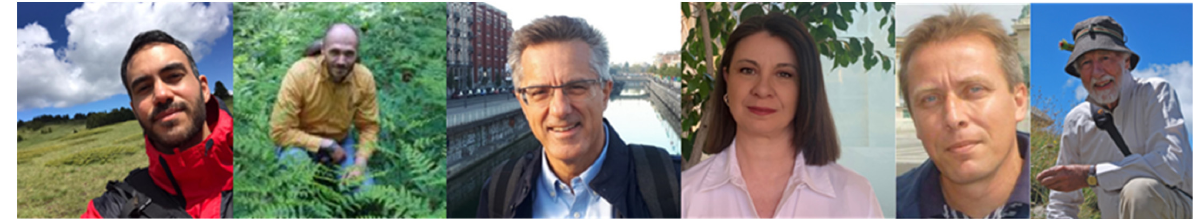
Figure 3. Konstantinos Kougioumoutzis, Ioannis Kokkoris, Panayotis Dimopoulos, Maria Panitsa, Panayiotis Trigas and Arne Strid (from left to right).